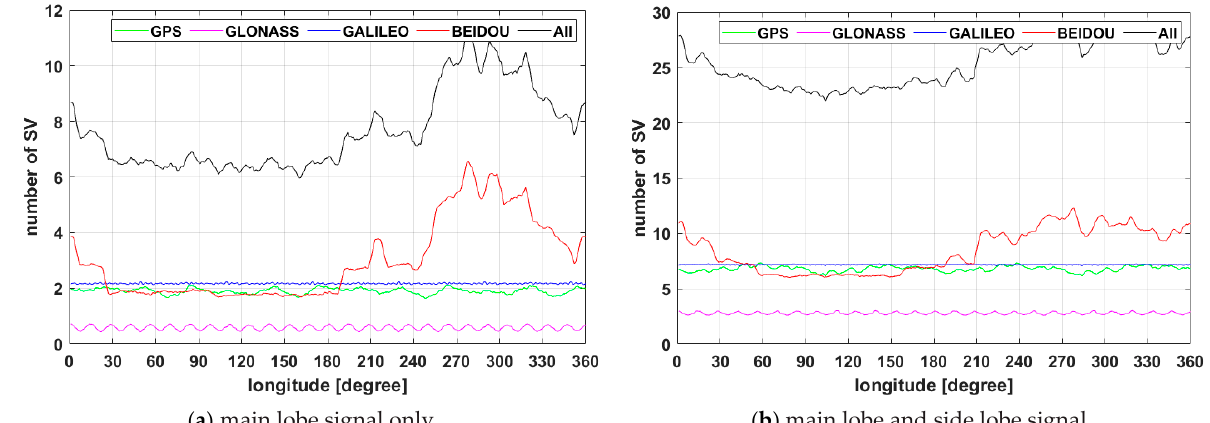
Figure 4. GNSS satellite visibility for 24 h in Geostationary orbit with longitude.